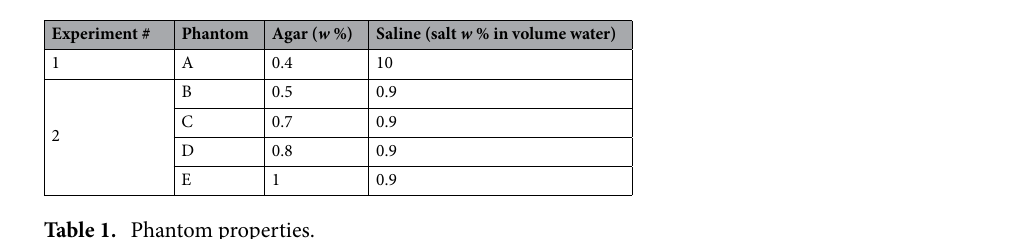
Table 1. Phantom properties.